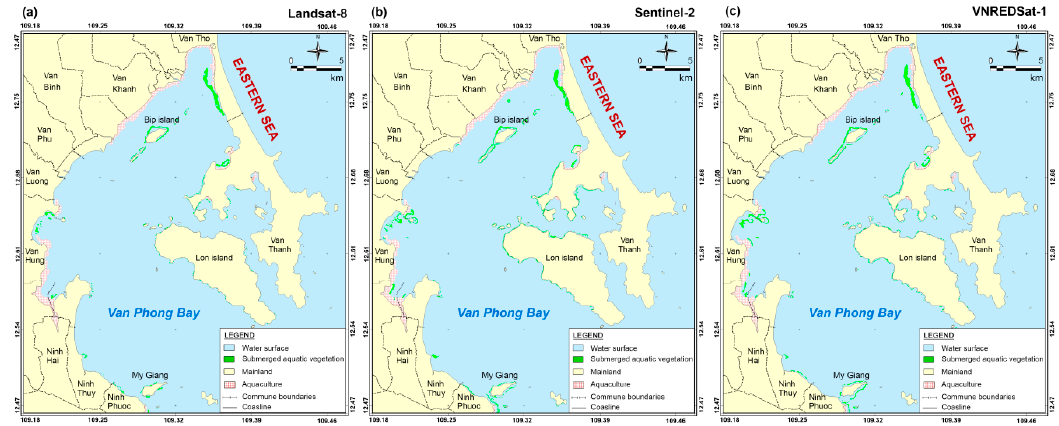
Figure 6. SAV distribution maps for Van Phong Bay, using data from three satellites: (a) Landsat-8 (2018), (b) Sentinel-2 (2019), (c) VNREDSat-1(2017).